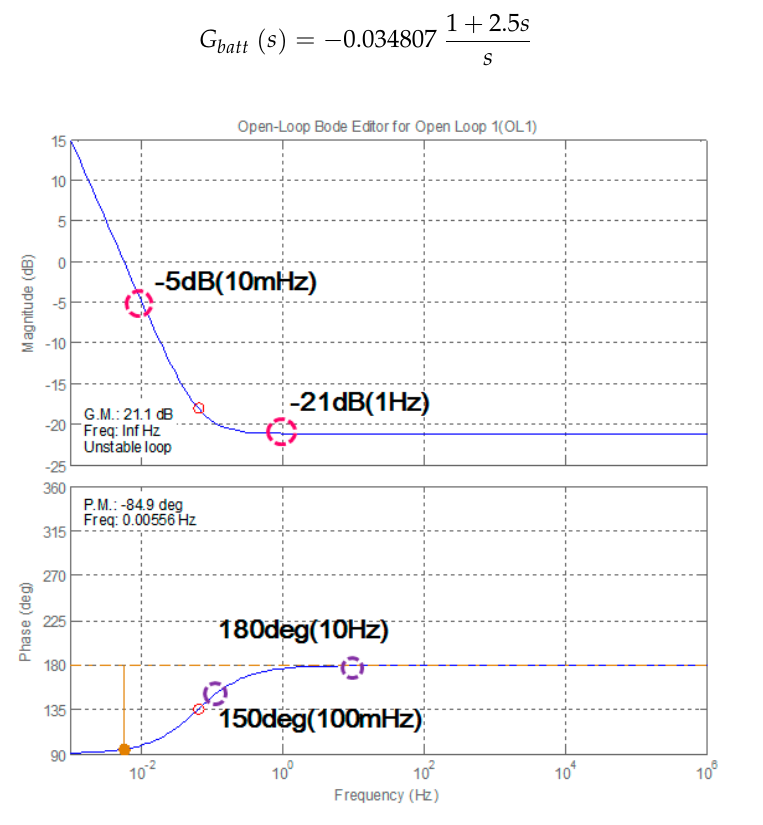
Figure 3. Frequency response approximation result of the battery pack at the nominal voltage.